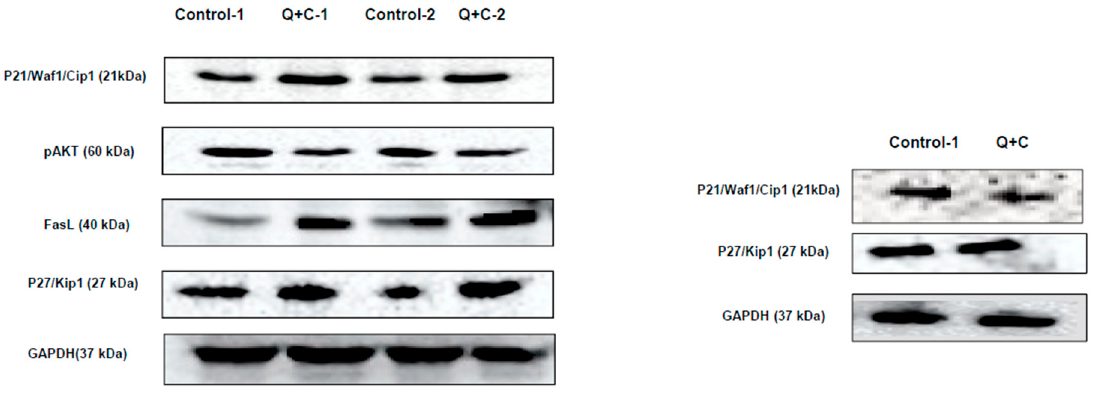
Figure 1. Representative Western blot analysis results for the protein levels of p21/waf1/cip1, p-AKT, FasL, P27/Kip1, btg2, Fas, IF γ in K562